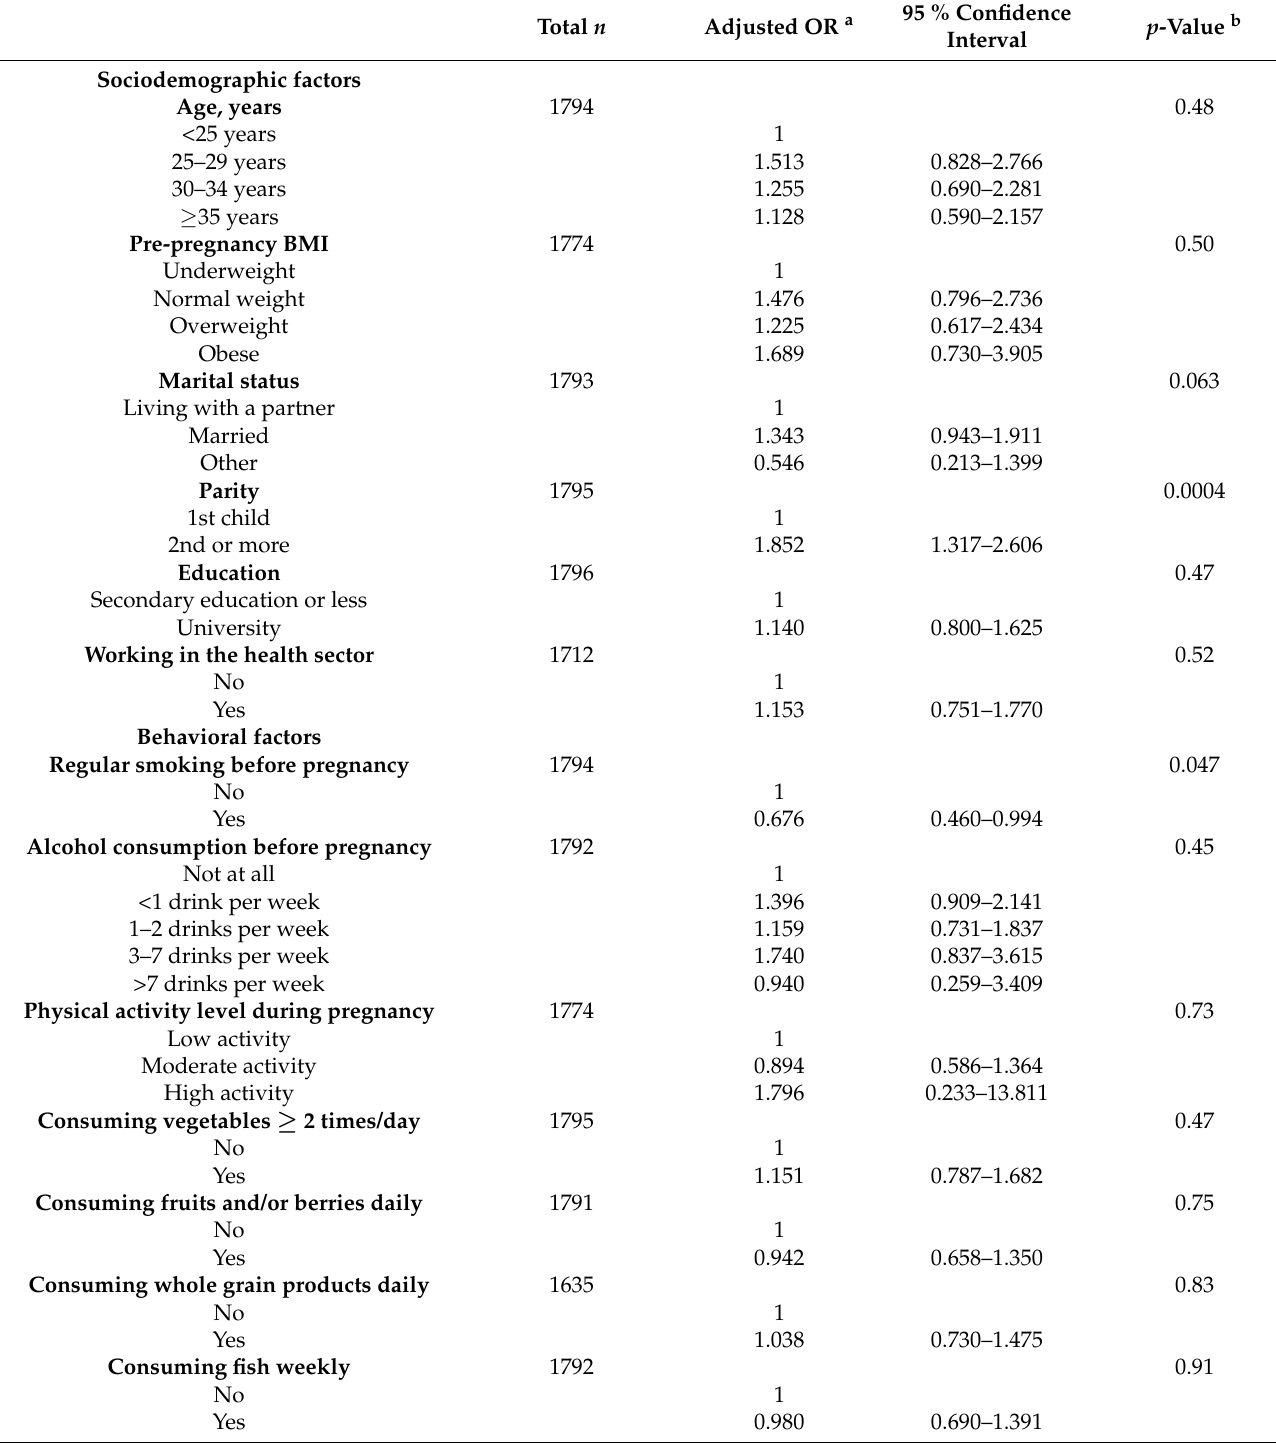
Table 5. Likelihood of any food supplement use according to selected sociodemographic and behav- ioral factors characterizing pregnant women in four European